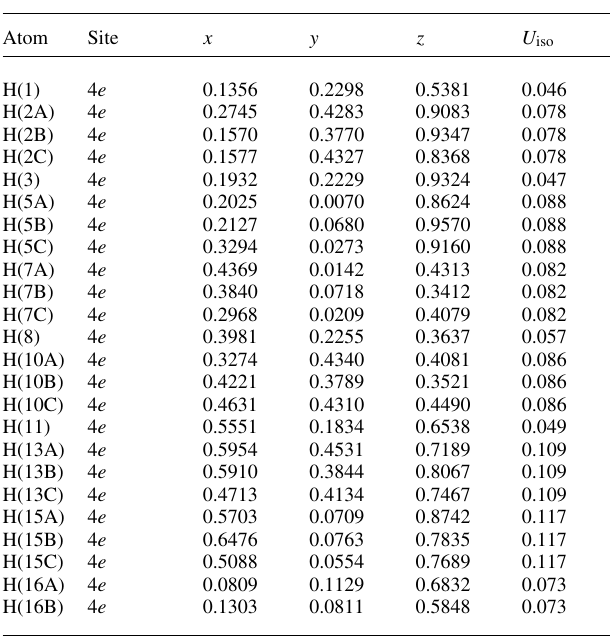
Table 2. Atomic coordinates and displacement parameters (in Å 2 )